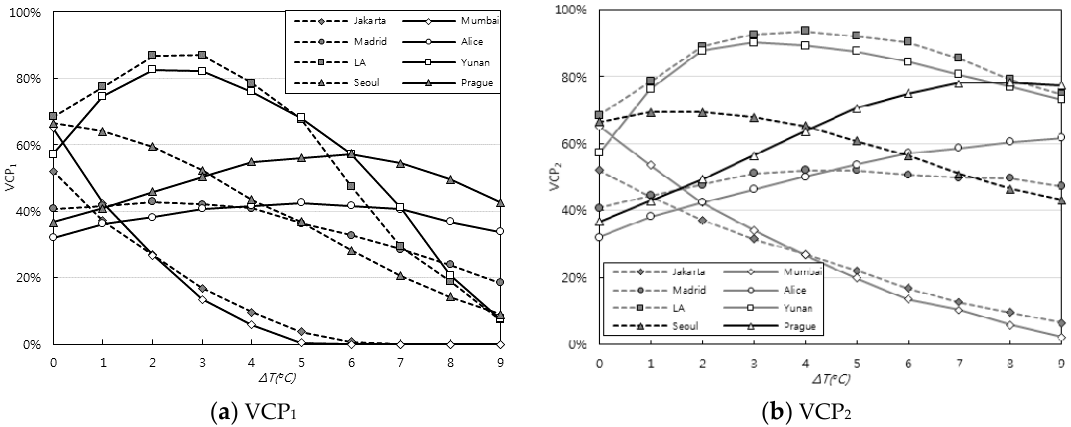
Figure 5. Variations of VCP 1 and VCP 2 with respect to Δ T in various cities.